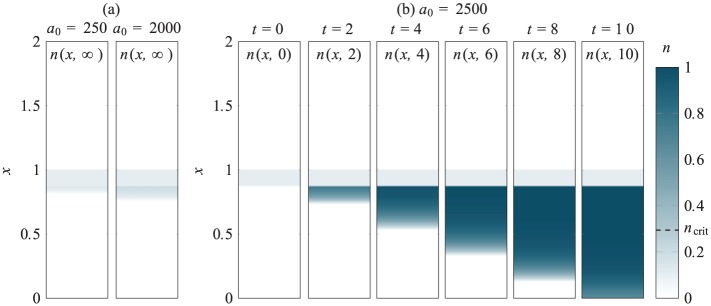
Chondrocyte densities for case study 3, where MSC differentiation is induced through the initial addition of exogenous TGF-β of concentration a0 in the region 1<x<2, and chondrocytes seeded in the region 0.875<x<1 at density n0=0.1: (a) Examples of partially differentiated steady states for a0=250and2000 and (b) for a0=2500, the initial MSC population is driven to full differentiate, this process shown at six time steps. Note that in the last time step shown here, a few MSCs remain, but these will differentiate at later times.